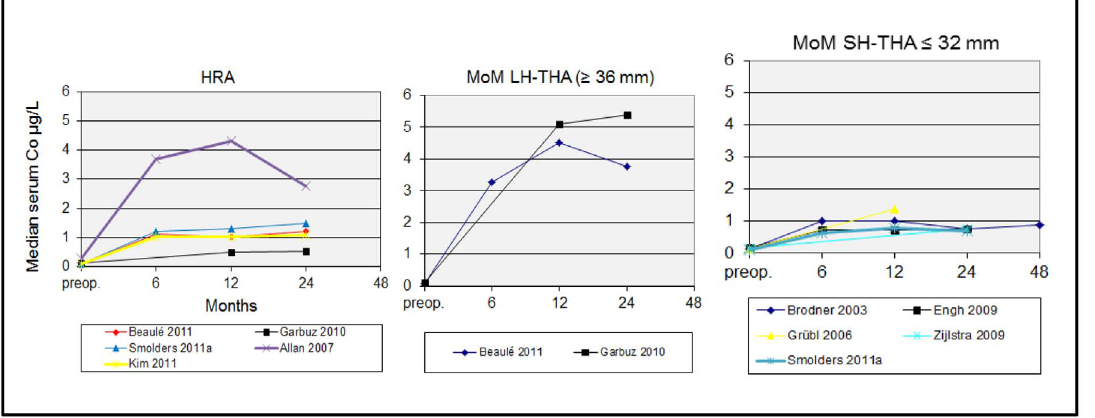
Figure 2. Course of median serum Co-concentration after implantation of hip replacements with different kinds of metal-on-metal bearings. Figure 2 provides an overview of the course of metal ion concentrations in studies reporting baseline serum Co-values and at least 2 postoperative Co-measurements. All MoM-interventions showed an increase in median serum Co-concentration. Again, highest median levels were observed in patients with HRA or MoM LH-THA. In some studies median Co-concentrations peaked at 12 months follow-up and declined thereafter. Other studies showed stable (increased) median serum Co-concentrations until 4-years follow-up.